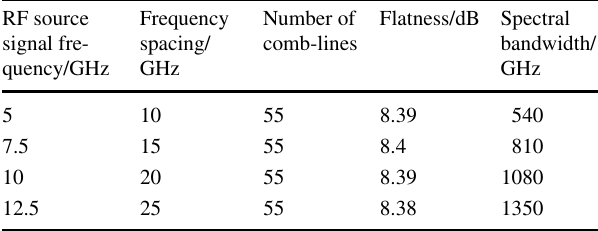
Table 1 Comparison of the frequency spacing, number of comb- lines, flatness and spectral bandwidth of the OFC for different fre- quencies of the RF source